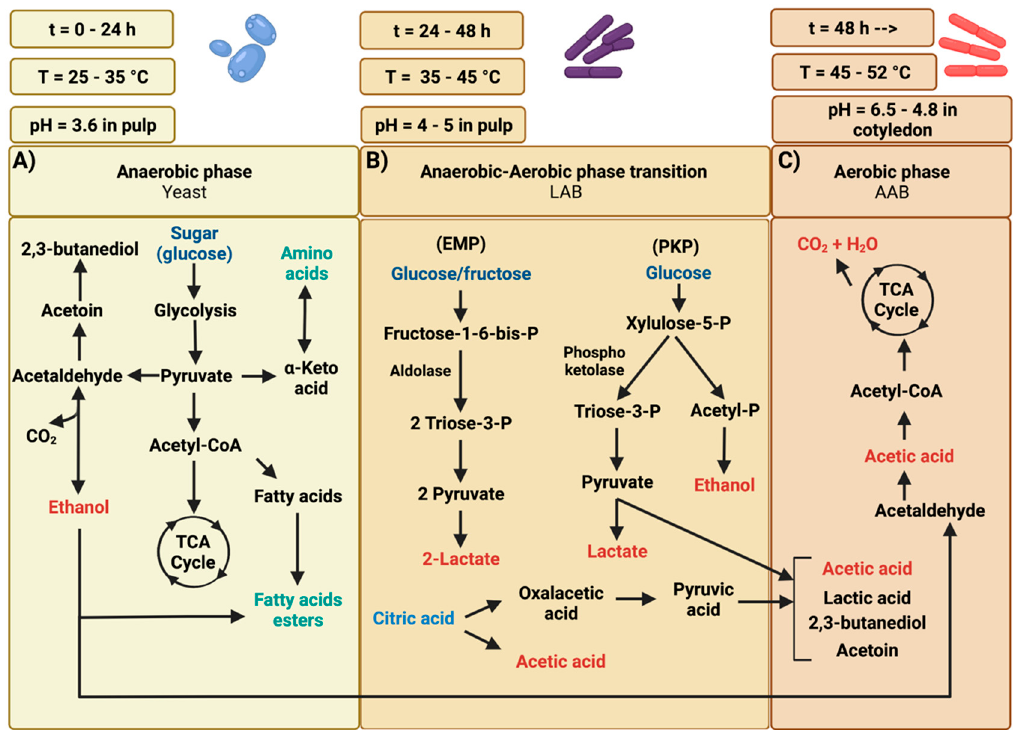
Figure 2. Main phases of cocoa fermentation. ( A ) Yeasts produce ethanol from sugar (glucose), fermenting it to pyruvate through glycolysis to obtain ATP, reduce equivalents production, and produce ethanol and carbon dioxide. ( B ) LAB strains utilize glucose through the Embden–Meyerhoff–Parnas EMP pathway (Homofermentative LAB) or phosphoketolase PKP pathway (Heterofermentative LAB). ( C ) Lastly, AAB strains oxidize ethanol produced by yeasts to acetic acid.